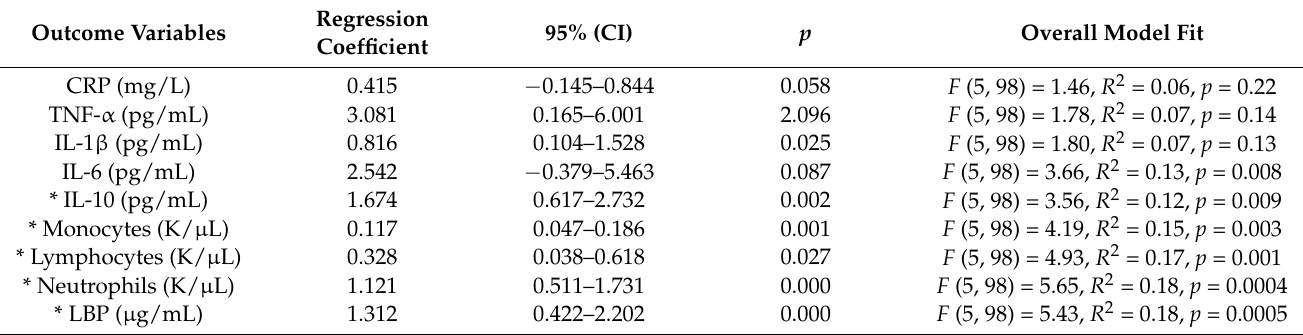
Figure 3. Assessment of leukocyte proliferation and systemic endotoxemia as a function of shift-work exposure. Data ( n = 104; 57 shift workers) represent group means ± standard error. Differences were assessed by the student’s t -test for independent samples. Respective p values indicate statistical significance. Table 3. Multivariate regression estimates of the effect of shift-work exposure on inflammatory outcomes, leukocyte counts, and LBP as a proxy for systemic endotoxemia after adjusting for